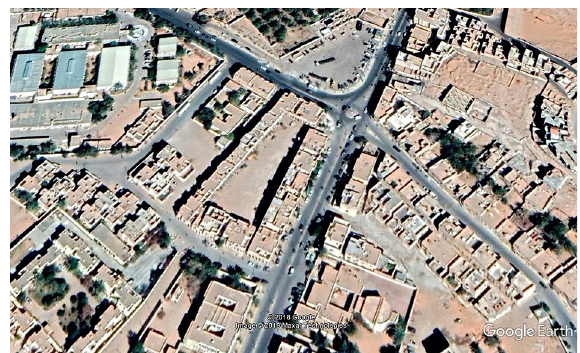
Fig. 5. Place of August 20 of Metlili.